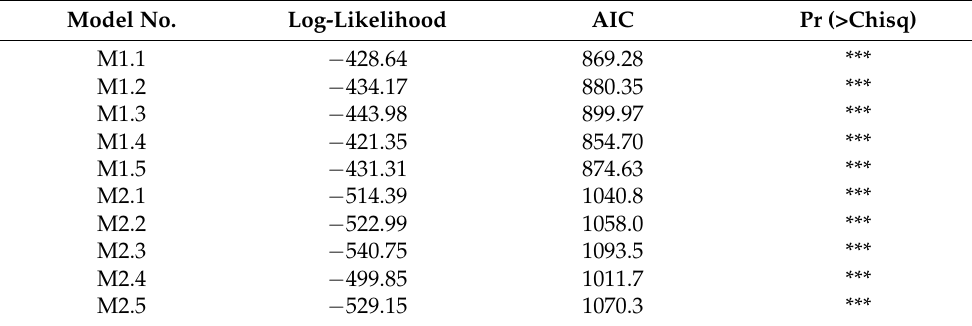
Table 6. Overview of CLMM models’ performance represented by log likelihood and AIC. Model